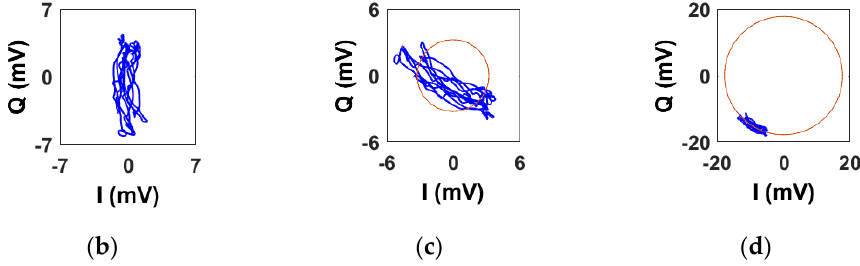
Figure 6. Example of baseband signals in the IQ plane obtained with the sub-10 GHz radar after applying the DC calibration methods. ( a ) AC coupling. ( b ) Linear demodulation. ( c ) Algebraic distance. ( d ) Geometric distance.